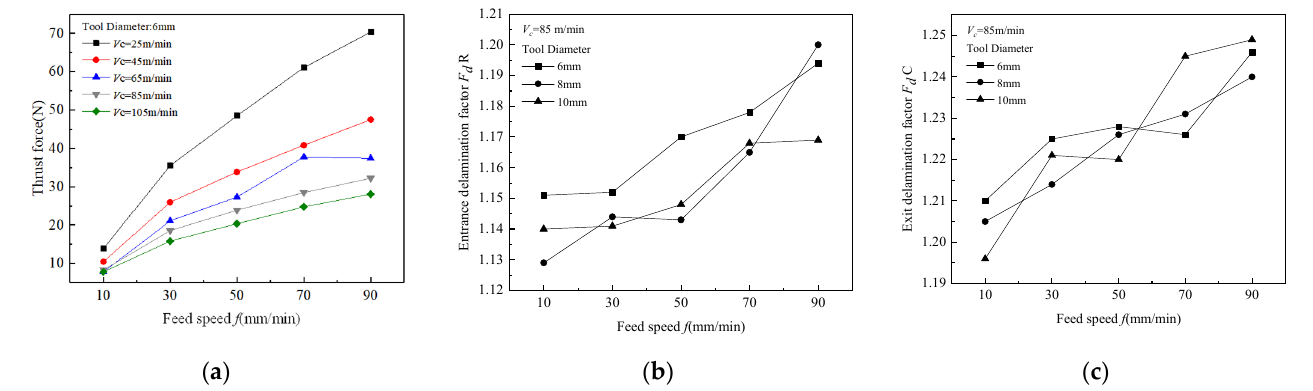
Figure 7. Entrance and exit delamination factors at different feed rates. ( a ) Effect of feed rate on thrust force at different cutting speeds. ( b ) Entrance delamination factors at different feed rates. ( c ) Exit delamination factors at different feed rates.